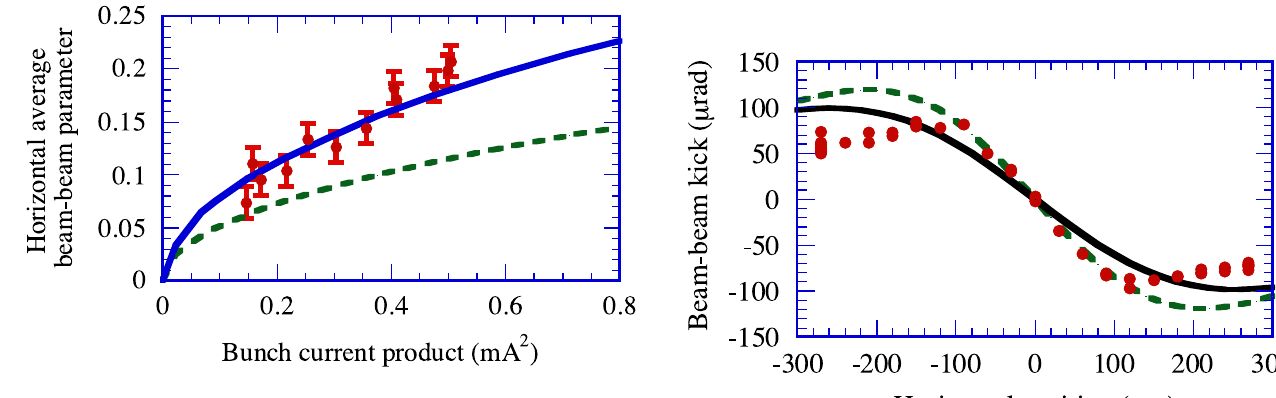
FIG. 11. (Color) The red dots represent horizontal average beam-beam parameter as a function of the product of bunch currents with low emittances of (cid:8) þ x 0 ¼ 15 nmrad and (cid:8) (cid:3) x 0 ¼ 18 nmrad . The blue line represents the horizontal beam-beam parameter calculated using the beam size considering the dy- namic beam-beam effect. The green dashed line is the beam- beam parameter calculated using the nominal beam size. The tune of the H mode is used in the calculation of the dynamic beam size.